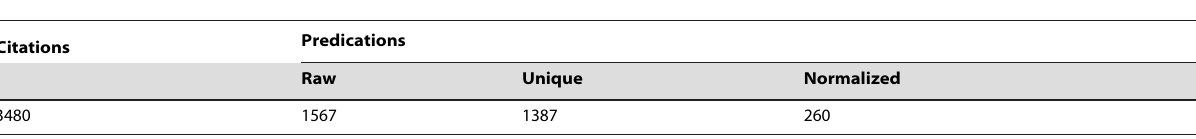
Table 2. Number of predications for yeast cell cycle pathway.